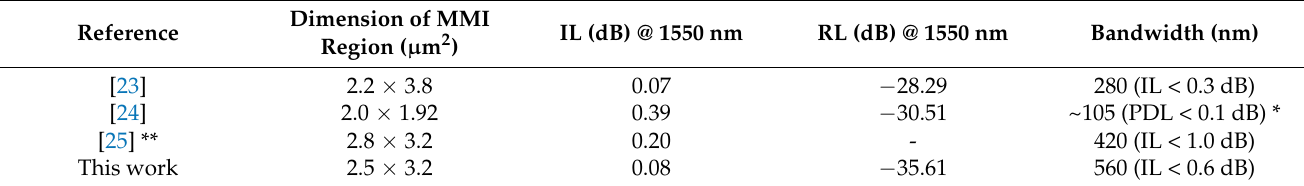
Figure 7. Wavelength dependence of IL for the conventional MMI power splitter (I) and the proposed device (II). The inset shows the corresponding device schematics. Table 1. Device comparison of typical MMI power splitters embedded with SWG structure.